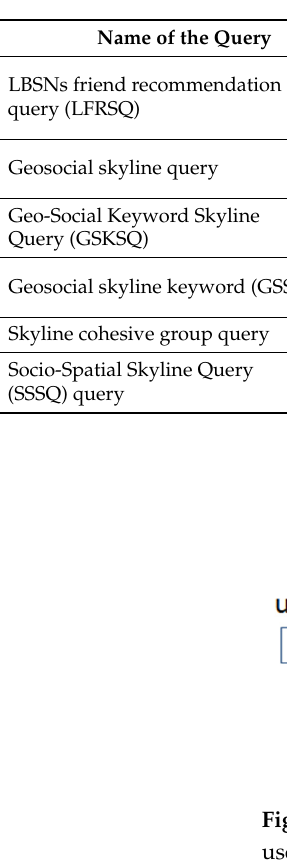
Table 12. Geosocial skyline queries.